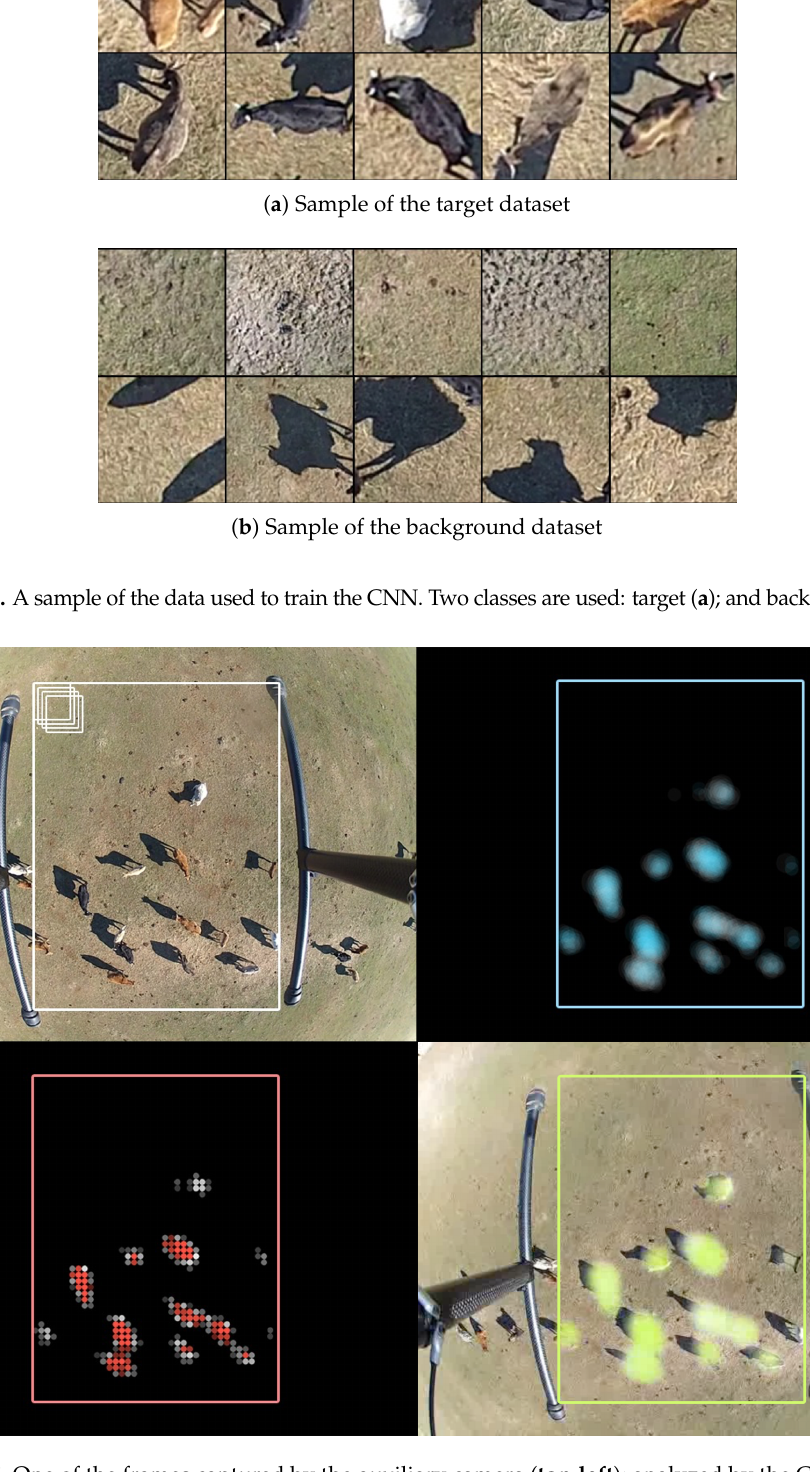
Figure 7. One of the frames captured by the auxiliary camera ( top-left ); analyzed by the CNN over a grid pattern producing a probability distribution L xys ( top-right ); values which can then be boosted and quantized as B xy to differentiate every single target ( bottom-left ); and visualization of the result for the user ( bottom-right